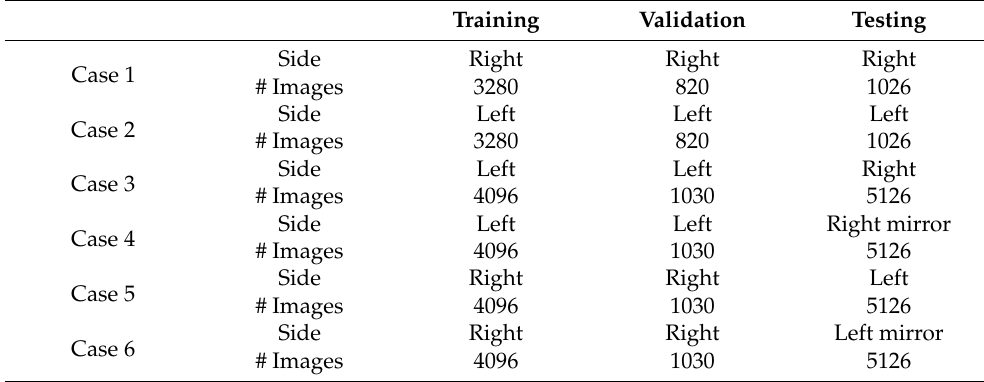
Table 9. Division of the UBIPr dataset into training, validation, and testing sets for the different cases used in the cross-eye experiment.